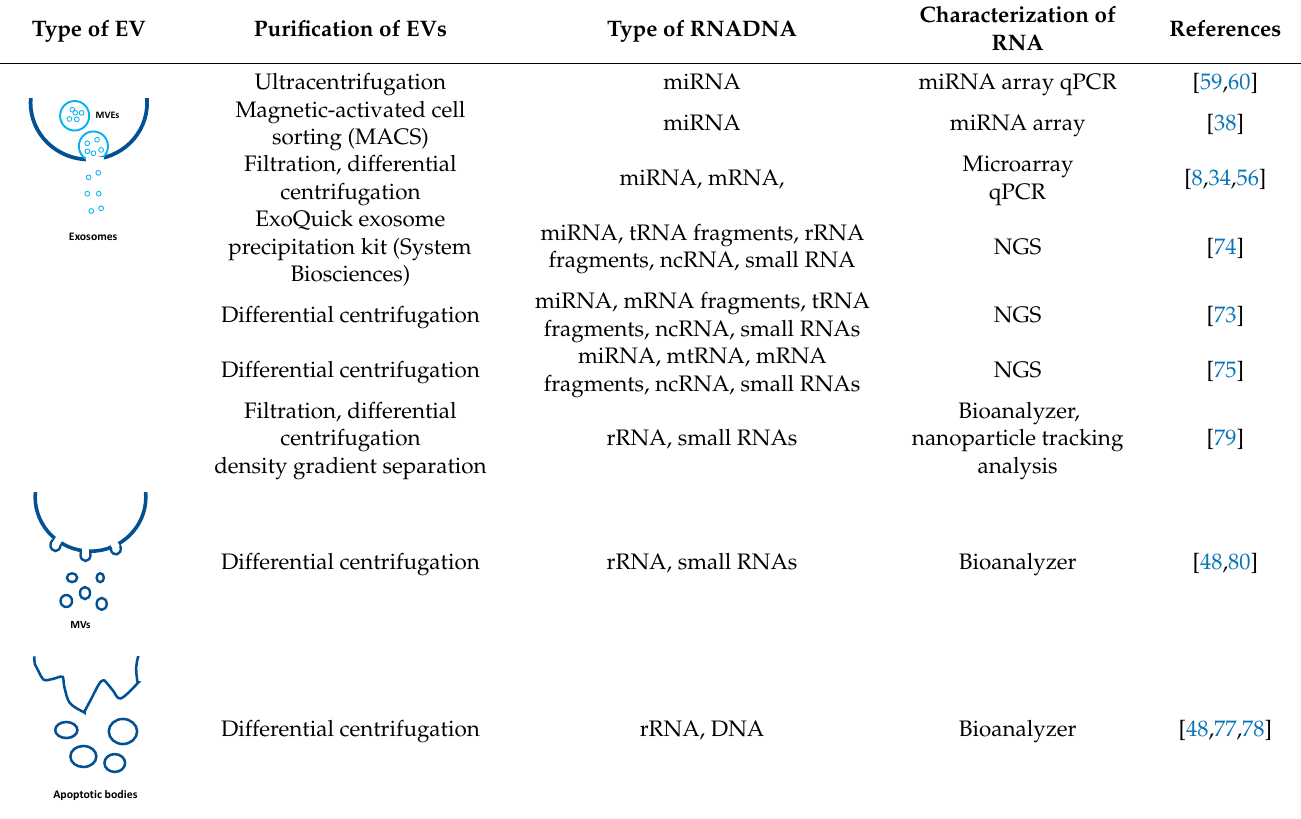
Table 1. Type of RNA in different EVs. Exosomes (30–150 nm) originate from the endosomal pathway by fusion of multivesicular bodies (MVBs) with the plasma membrane, microvesicles (MVs, 100–1000 nm) are formed by cell surface membrane blebbing, and apoptotic bodies (500–2000 nm) are vesicles released from apoptotic